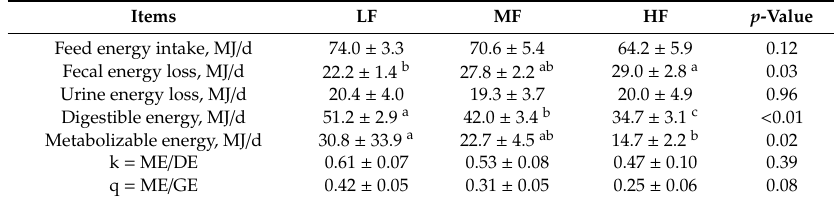
Table 5. Energy balance in adult donkeys fed low- (LF, F / C = 35:65), medium- (MF, F / C = 55:45) and high-fiber (HF, F / C = 80:20) diets with di ff erent forage / concentrate ratio (F /